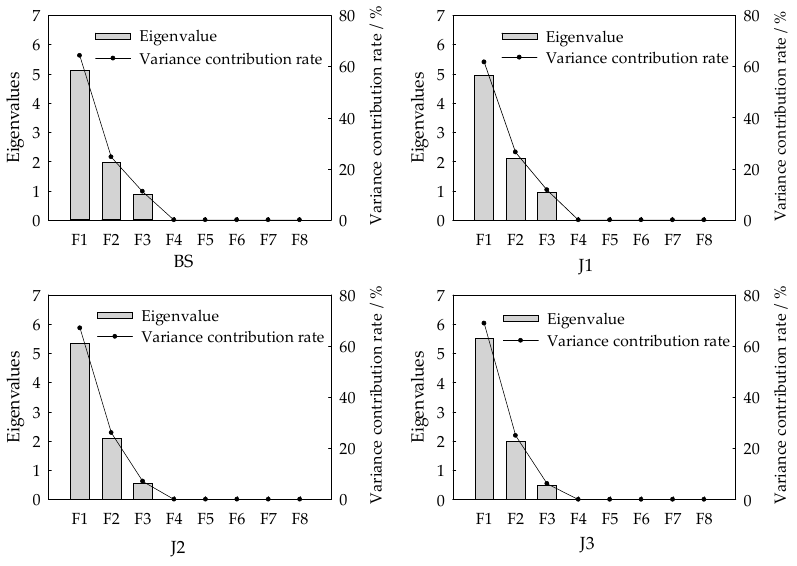
Figure 7. Variance contribution rate and eigenvalues in P1.